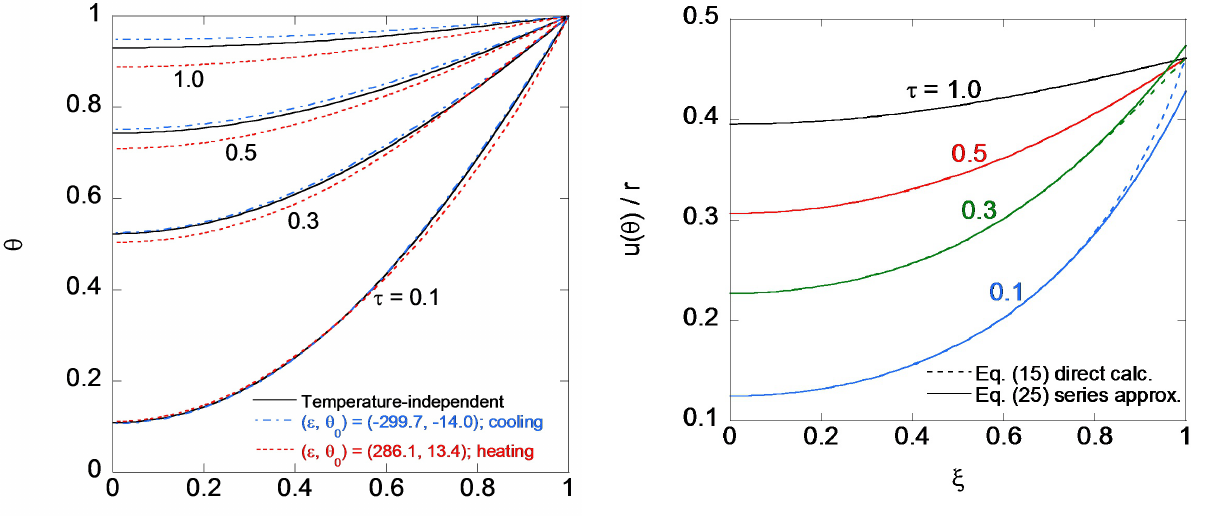
Fig. 7. Spatial profiles of nonlinear function, u , at different times for ε = 286.1, θ 0 = 13.4, r = 5.1 × 10 −9 and α =